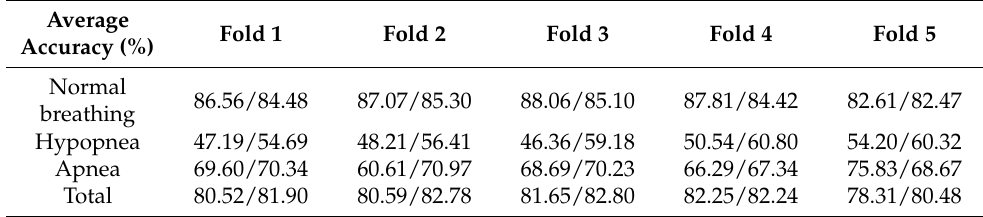
Table 3. Three-class inference performance of each instance of the model. Values for SHHS-1/Physionet datasets.